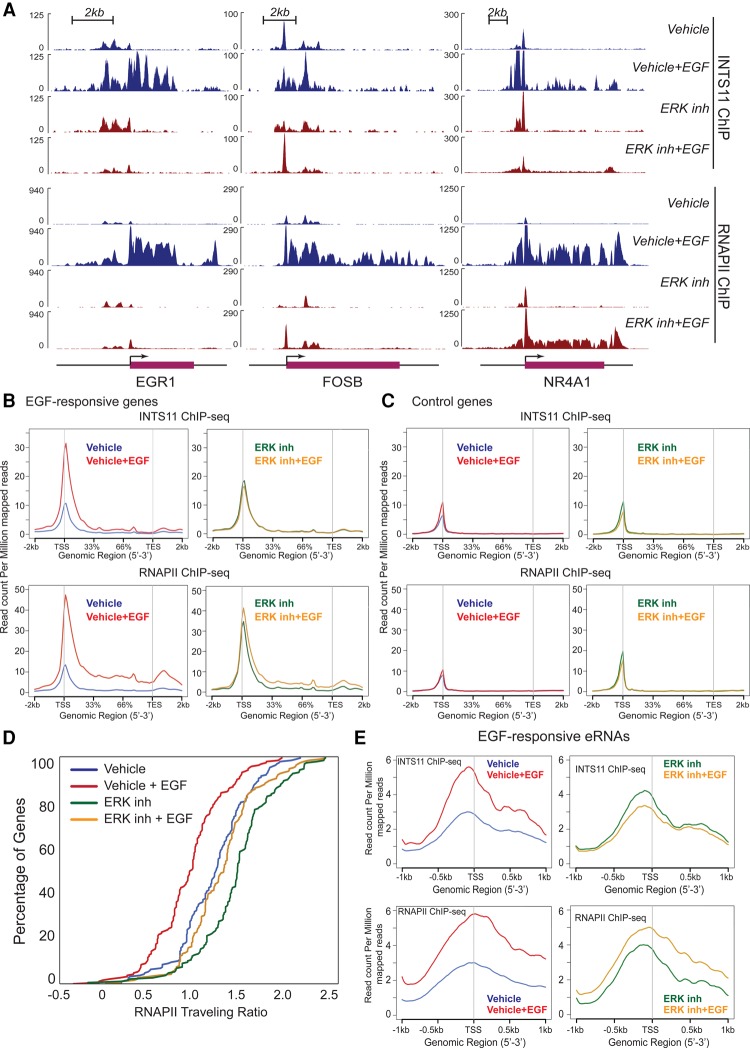
Pharmacological inhibition of the MAPK pathway diminishes stimulus-induced Integrator recruitment. All experiments were performed in at least two biological replicates. (A) The presence of ERK inhibitor (SCH772984) affects the dynamics of INTS11 and RNAPII recruitment at EGR1, FOSB, and NR4A1 loci. Diagrams of the EGR1, FOSB, and NR4A1 genomic regions are at the bottom. (B,C) Average profiles of INTS11 (top) and RNAPII (bottom) recruitment at 106 EGF-induced genes (B) and 106 control genes that were randomly selected (see the Materials and Methods for more details). (C). ChIP-seq was performed before and after 20 min of EGF induction with or without ERK inhibitor treatment. (D) The RNAPII traveling ratio at 106 EGF-induced gene loci was measured. The ratio was calculated as log10 of read density at the transcription start site (TSS)/read density over the gene body. All distributions were significantly different. P < 0.001, Kolmogorov-Smirnov test. (E) Average profiles of INTS11 or RNAPII recruitment at 57 EGF-induced enhancers (see the Materials and Methods).